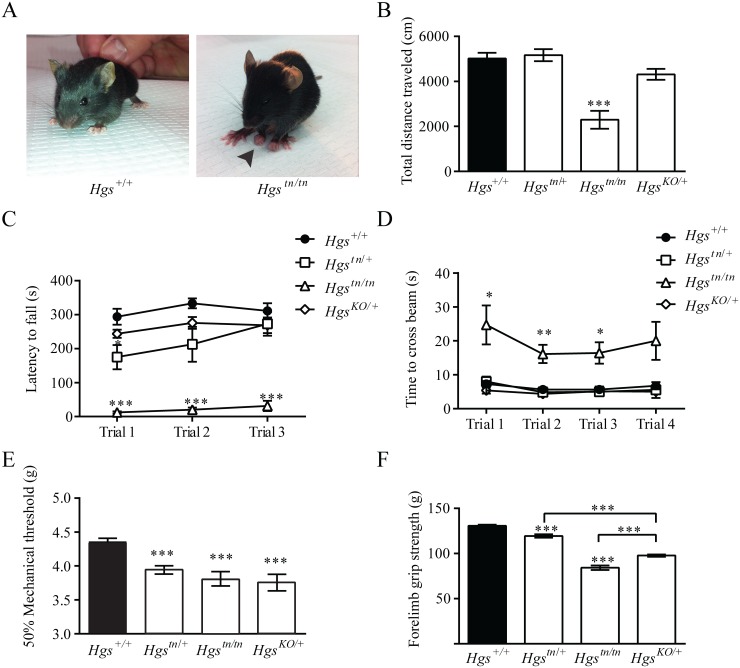
Gene dosage effects of HGS expression on motor and sensory function in 3- to 4-week-old mice.(A) Reduced HGS expression results in clawed paws in Hgs
tn/tn mice. Behavioral assays of (B) open field, (C) rotarod, (D) elevated beam, (E) von Frey and (F) forelimb grip strength for Hgs
+/+ (black), Hgs
tn/+, Hgs
tn/tn and Hgs
KO/+ mice. n = 6 mice per genotype for all assays except rotarod, where n = 4. Symbols represent unpaired t-tests corrected for multiple comparisons using the Holm-Sidak method. Data are shown as mean ± SE and n>6 animals per genotype for all assays except rotarod, where n = 4. A two-way anova demonstrated a significant effect of genotype on rotarod and elevated beam performance. Data are shown as mean ± SE. *p<0.05, **p<0.01 and ***p<0.001.